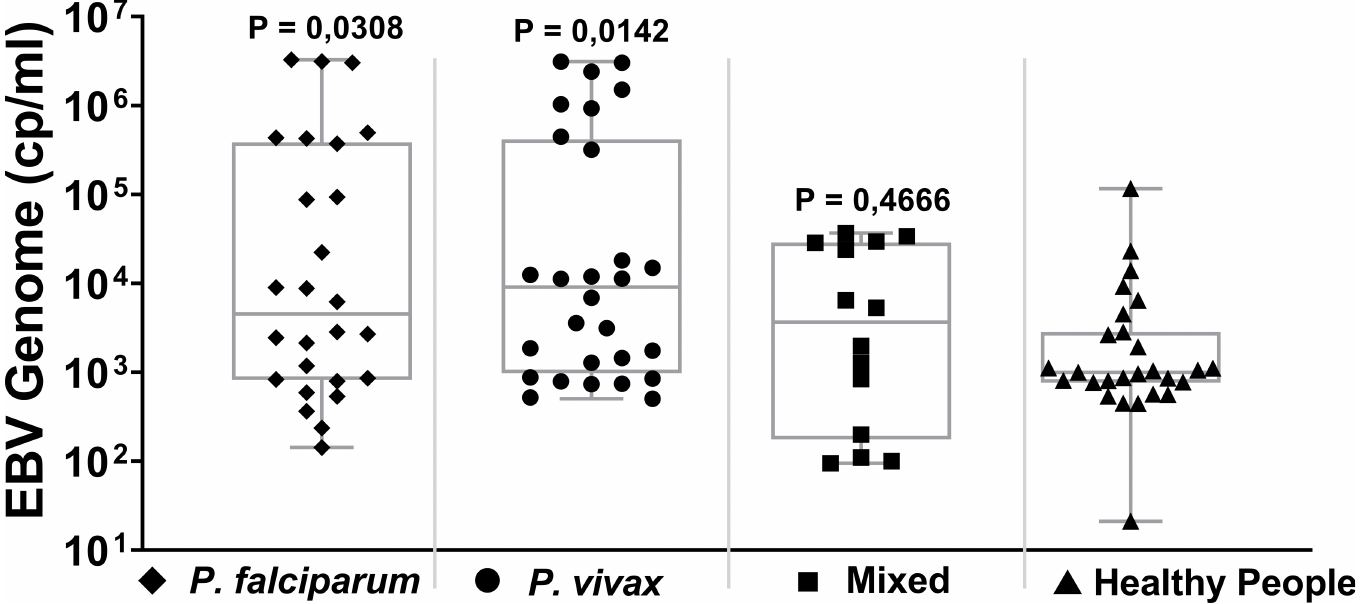
Fig 2. Quantitative EBV-DNA genome levels (copies/ml) in blood plasma in 3 groups of Malaria cases ( P . falciparum , P . vivax and Mixed) and regional controls. Box-limits represent the 95% confidence interval and the line represents the median level of EBV-DNA. Statistical analysis was done by one-Way ANOVA (cases versus